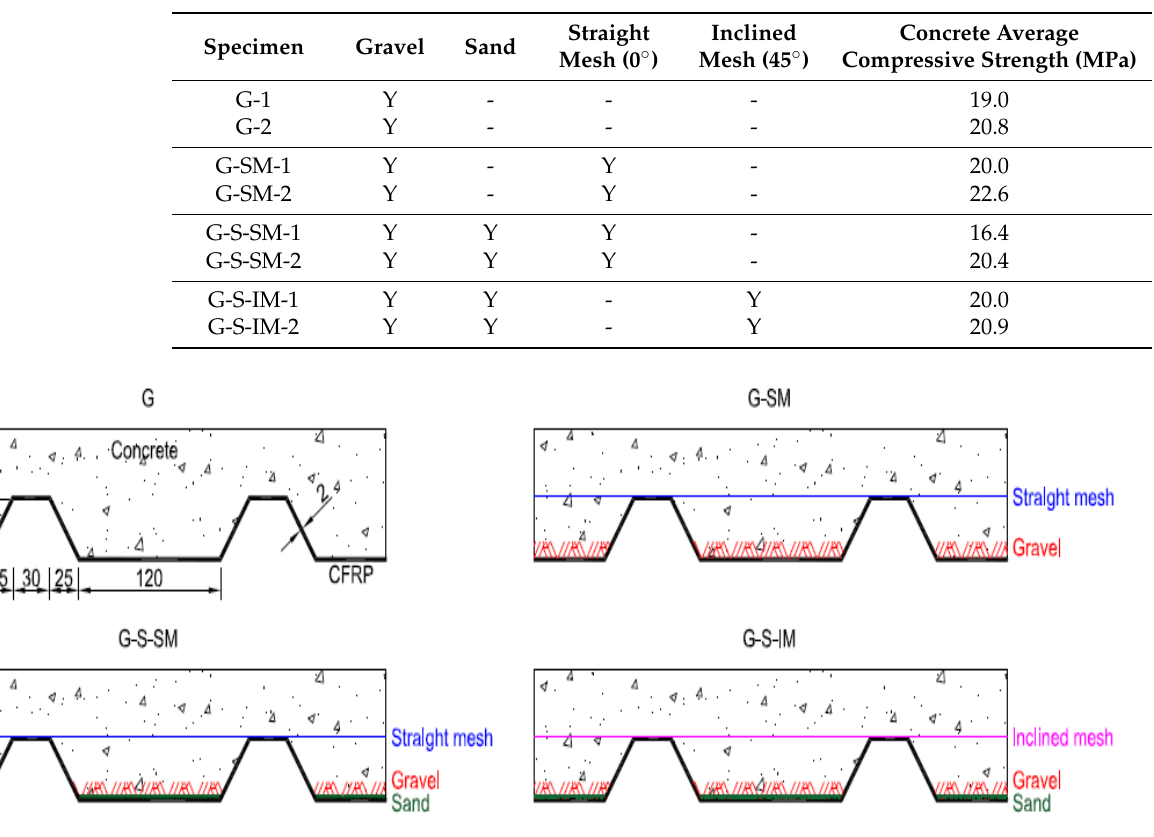
Figure 2. Connection system definitions and specimen cross-section dimensions (in mm).